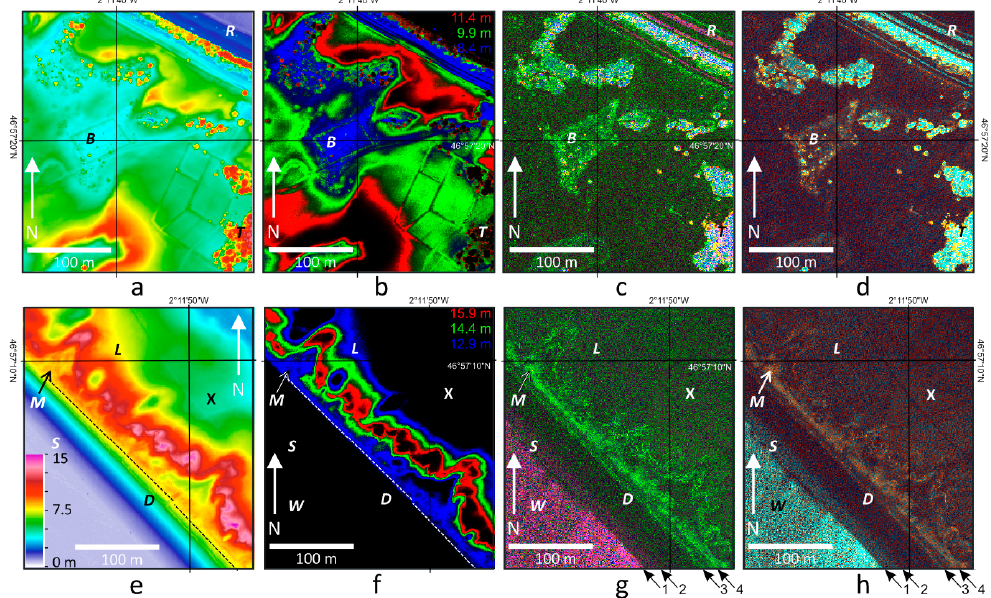
Figure 7. Summary of the FWF analysis: ( a , e ) DSM built on echoes of both AOIs located in Figure 1c with ROI and marram grass shoreline locations; ( b , f ) row FWF color composition using R, G, and B intensities taken on three different altitudes in each AOI; ( c , g ) dNCCFWF color composition using R: 1.15 m, G: 0.40 m, and B: − 2.15 m selection of Figure 6 c, showing sand and low-vegetation types in dark green, marram grass in light green, trees in blue, and water and asphalt in magenta; ( d , h ) color composition of R: LDI up , G: LDI mean , and B: LDI down . Arrows are boundaries 1: from water to wet sand; 2: from wet sand to dry sand, 3: from dry sand to couch grass; and4: from couch grass to marram grass.